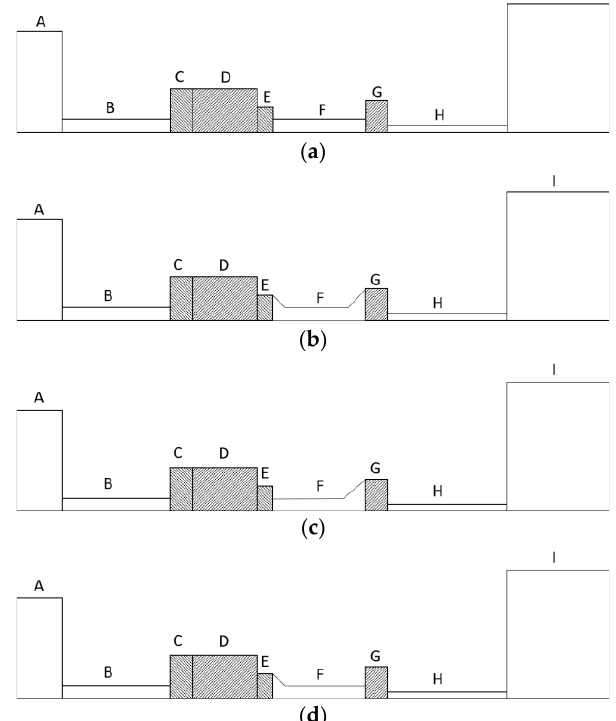
Figure 1. Four types of pulse tube structures. ( a ) Original Model. ( b ) Model 1. ( c ) Model 2. ( d ) Model 3. Table 1. Geometry dimensions and boundary conditions.